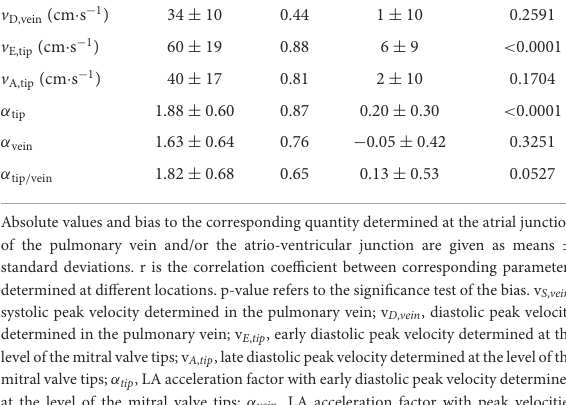
TABLE 4 Peak velocities in the pulmonary vein and at the level of mitral valve tips and the corresponding LA acceleration factors. Parameter Absolute r Bias p -value